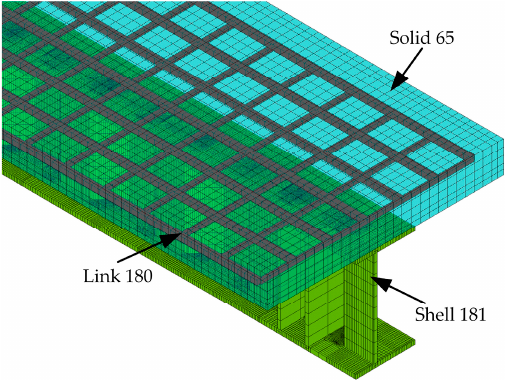
Figure 11. Finite element model.